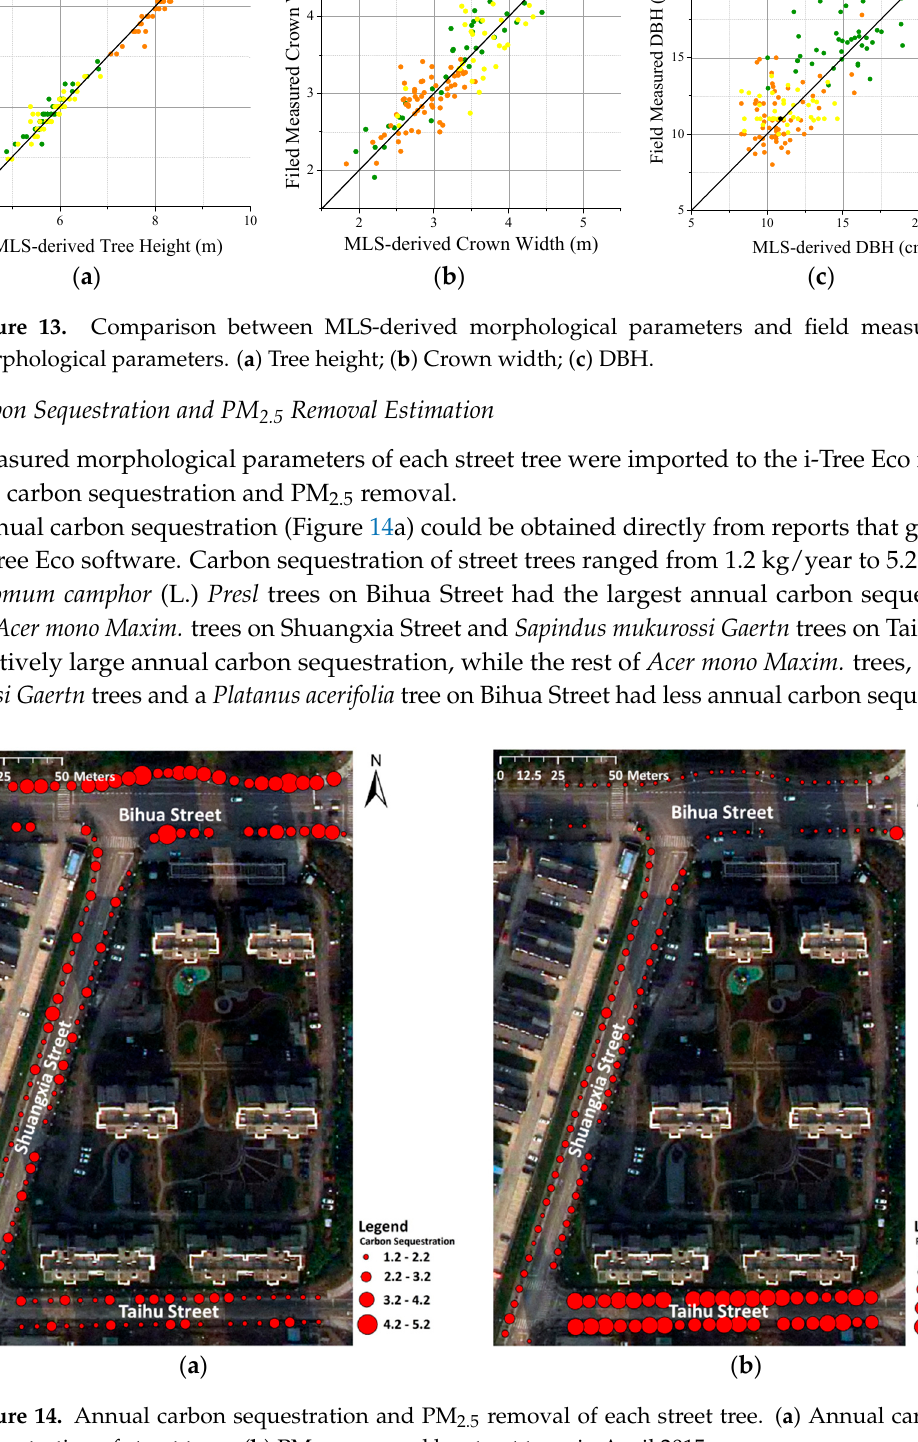
Figure 14. Annual carbon sequestration and PM 2.5 removal of each street tree. ( a ) Annual carbon sequestration of street trees; ( b ) PM 2.5 removed by street trees in April